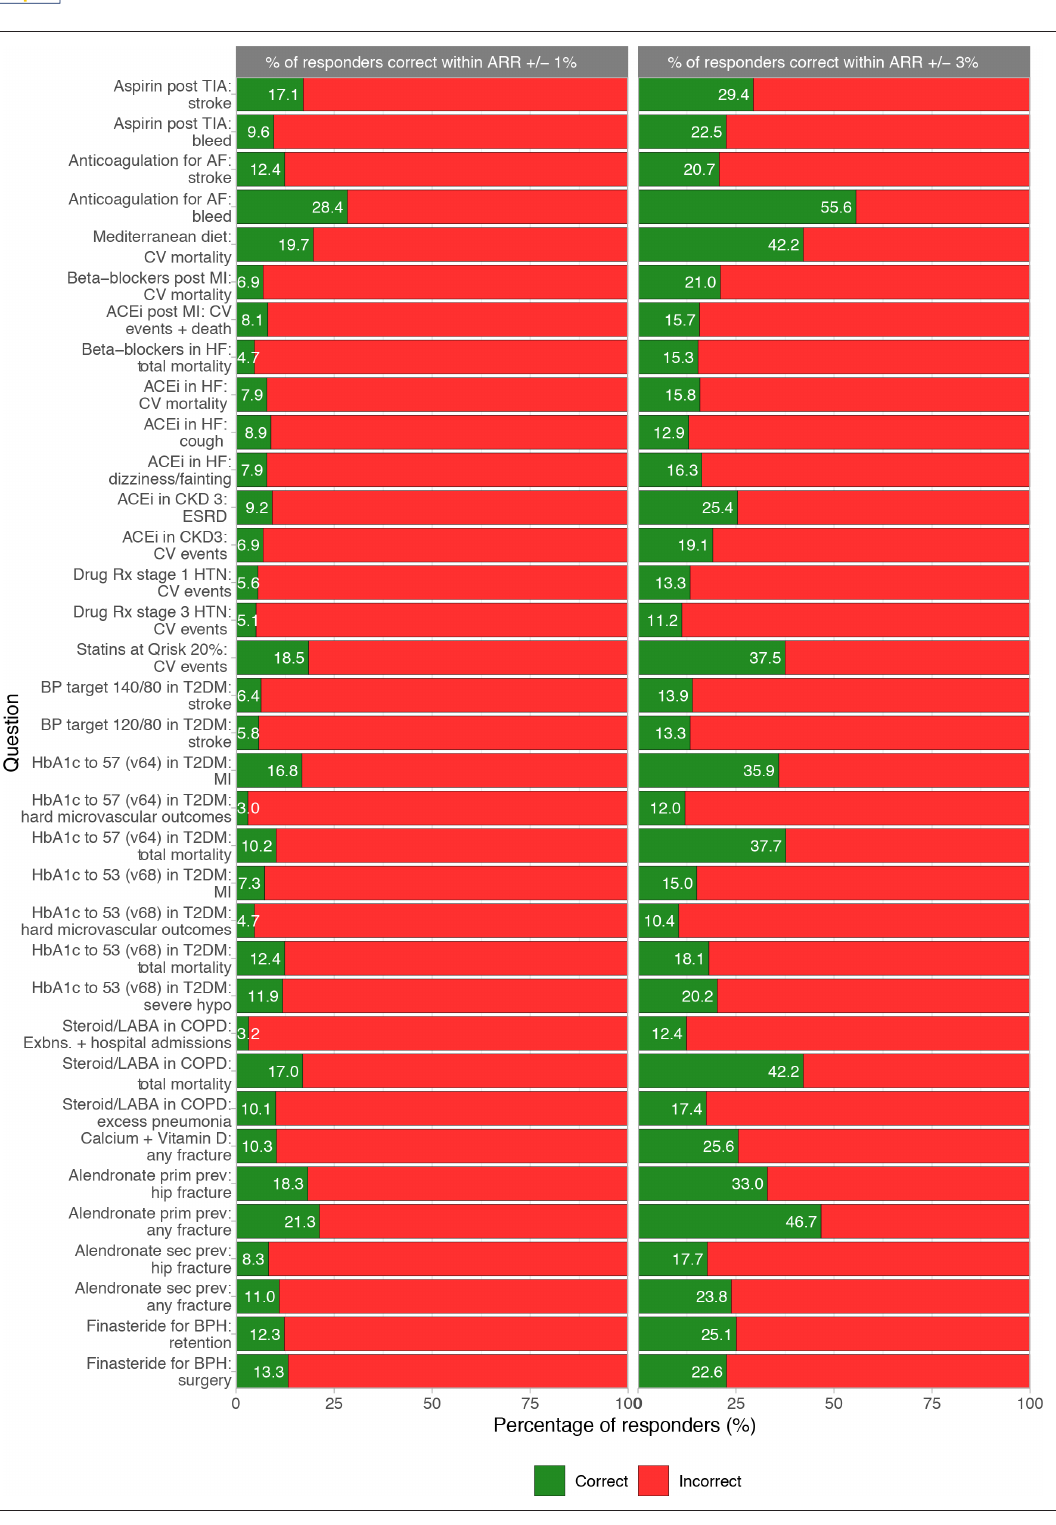
Figure 4 Percentage of correct responses per survey question. ACEi = angiotensin- converting enzyme inhibitors. AF = atrial fibrillation. ARR = absolute risk reduction. BP = blood pressure. BPH = benign prostatic hyperplasia. CKD = chronic kidney disease. COPD = chronic obstructive pulmonary disease. CV = cardiovascular. ESRD = end- stage renal disease. Exbns = Exacerbations. HF = heart failure. HTN = hypertension. hypo = hypoglycaemia. LABA = long- acting Beta 2 agonists. MI = myocardial infarction. prim prev = primary prevention. Rx = Treatment. Sec prev = secondary prevention. T2DM = type 2 diabetes mellitus. TIA = transient ischaemic